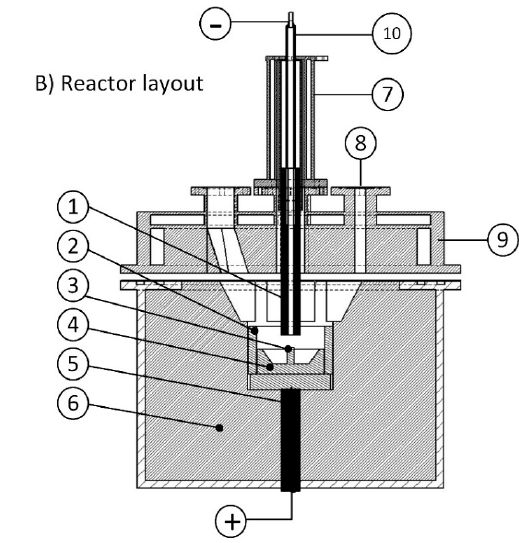
Figure 1. Schematic of laboratory-scale plasma facility at Montanuniversitaet Leoben: ( A ) process flow diagram and ( B ) reactor layout [10].